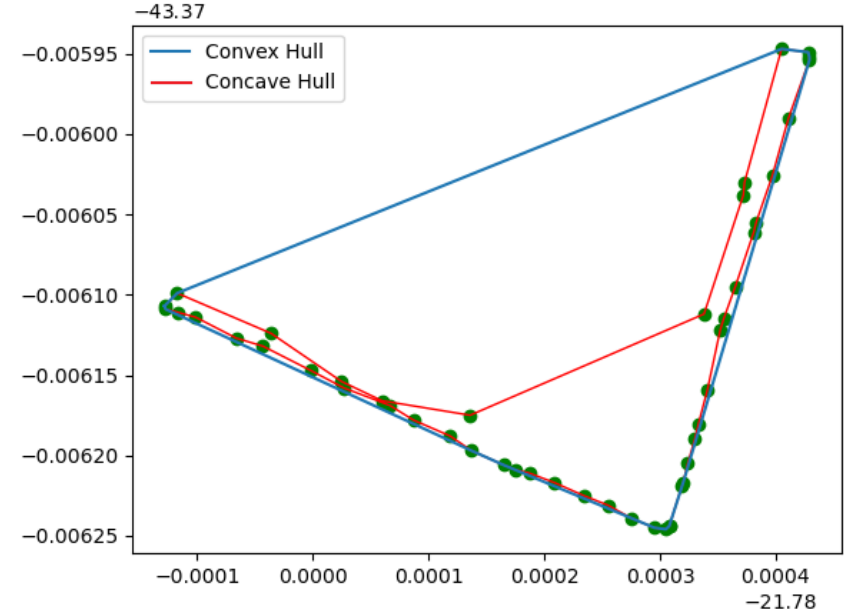
Figure 2. Comparison between Convave Hull and Convex Hull